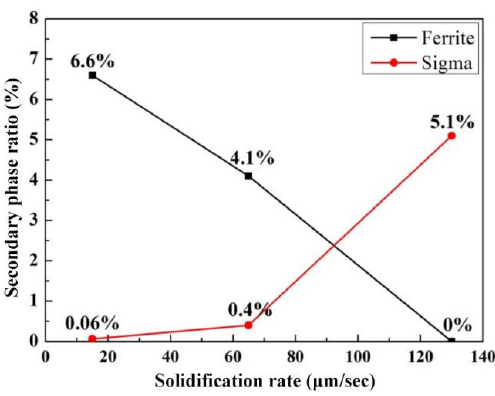
Figure 8. Effect of pulling rate on the proportion of the second phase. The proportion of σ phase in the solidification structure is positively correlated with the pulling rate. As the pulling rate increases from 15 μ m/sec to 65 μ m/sec, the proportion of σ phase in the steel increases slightly, and the second phase of the solidified structure is mainly ferrite. When the pulling rate reaches 130 μ m/sec, the ferrite phase of the solid ‐ ified structure basically disappears completely, and the proportion of the σ phase reaches 5.1%.